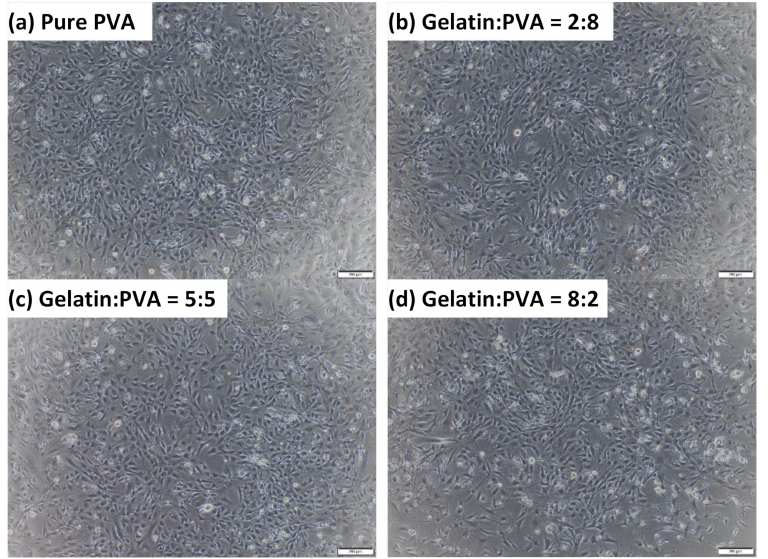
Figure 12. Selected optical images (50 × ) of cultured 3T3 in media from immersed gelatin/PVA = 8:2, 5:5, 2:8, and pure